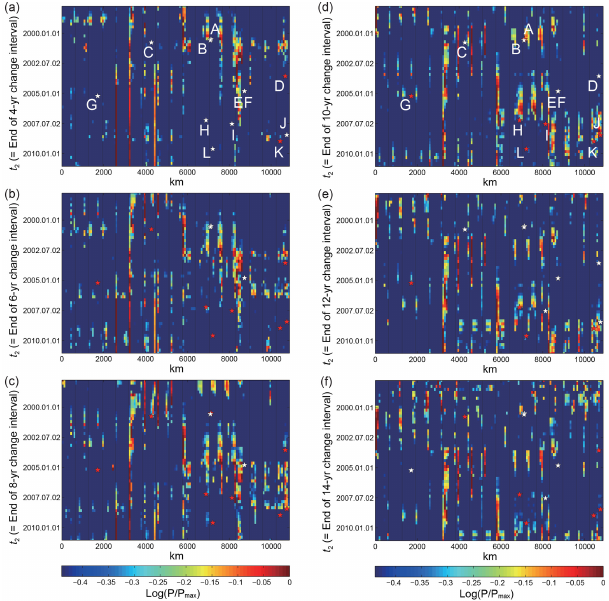
Fig. 4. As in Fig. 3, but for a cutoff magnitude of 4.0. Fig. 5. As in Fig. 3, but for a cutoff magnitude of